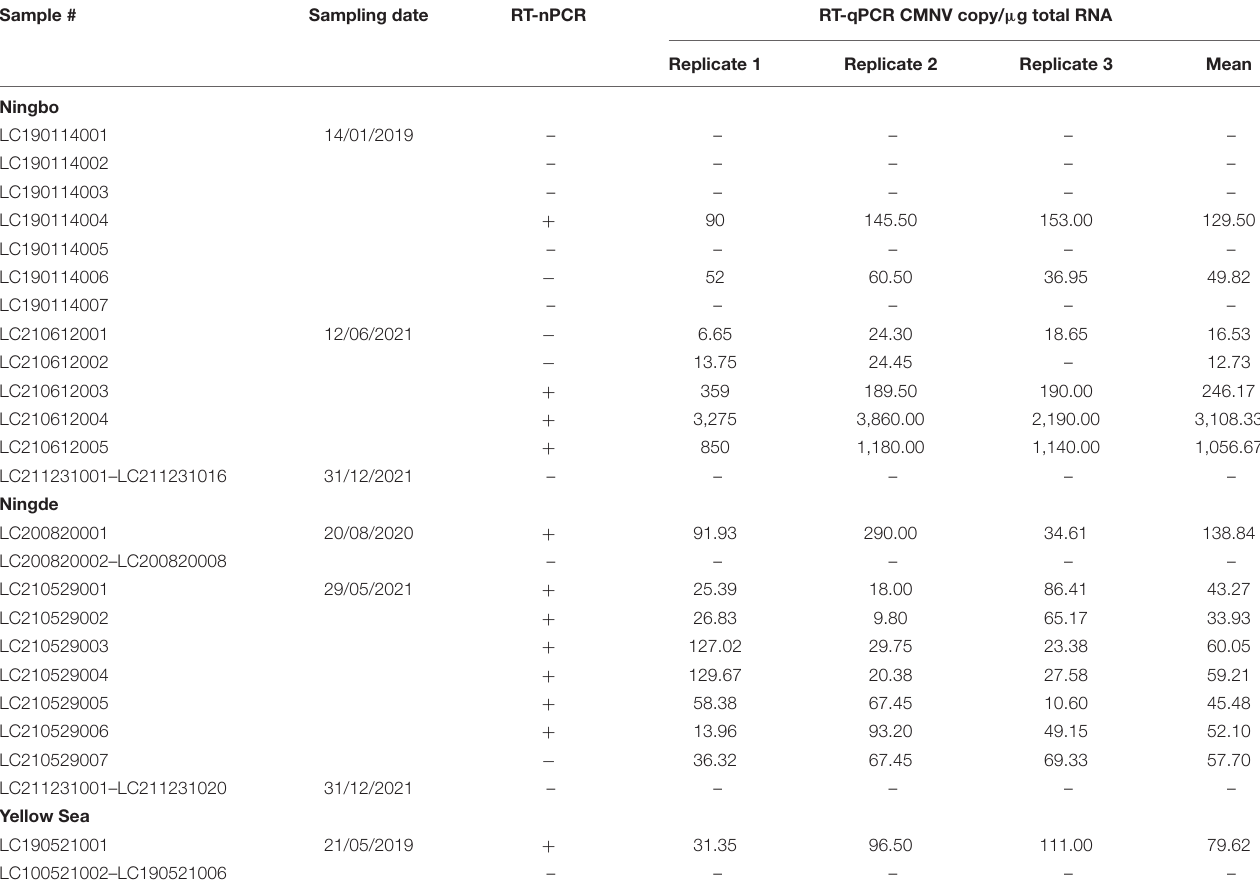
TABLE 2 | The results of RT-nPCR and TaqMan RT-qPCR